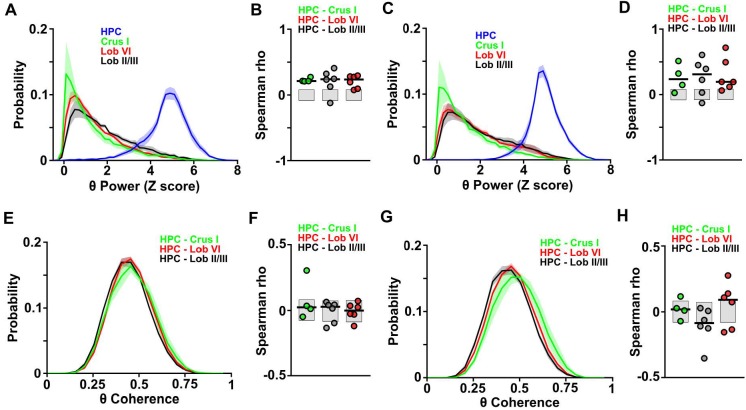
Distributions and correlations during goal-directed behavior.(A) Probability distribution of the instantaneous LFP theta power for each of the recorded regions during session one in the linear track. Hippocampal theta power followed a negatively skewed distribution while all cerebellar LFP theta power followed a positively skewed distribution. (B) Correlation between the instantaneous LFP theta power for each of the cerebellar regions and instantaneous speed during session one in the linear track. Gray-shaded bars represent the confidence levels obtained from bootstrapped data with α = 0.05. Cerebellar theta power was significantly positively correlated with speed across all recorded regions (Crus I, n = 4, median rho Spearman = 0.2125; lobule II/III, n = 6, median rho Spearman = 0.2391; lobule VI, n = 6, median rho Spearman = 0.2353). (C) Same as A for session 20. (D) Same as B for session 20. Cerebellar theta power was significantly positively correlated with speed across all recorded regions (Crus I, n = 4, median rho Spearman = 0.2349; lobule II/III, n = 6, median rho Spearman = 0.3097; lobule VI, n = 6, median rho Spearman = 0.1941). (E) Probability distribution of instantaneous hippocampal-cerebellar theta coherence (color coded) and instantaneous speed during session one in the linear track. All combinations followed gaussian distributions. (F) Correlation between the instantaneous hippocampal-cerebellar theta coherence (color coded) and instantaneous speed during session one in the linear track. Gray-shaded bars represent the confidence levels obtained from bootstrapped data with α = 0.05. Hippocampal-cerebellar theta coherence was not significantly correlated with speed across any of the recorded combinations. (G) Same as E for session 20. (H) Same as F for session 20. Lobule II/III-HPC theta coherence was significantly negatively correlated with speed (n = 6, median rho Spearman = −0.0859) and lobule VI-HPC theta coherence was significantly positively correlated with speed (n = 6, median rho Spearman = 0.0911). Crus I-HPC theta coherence was not correlated with speed (Spearman rho = 0.024).